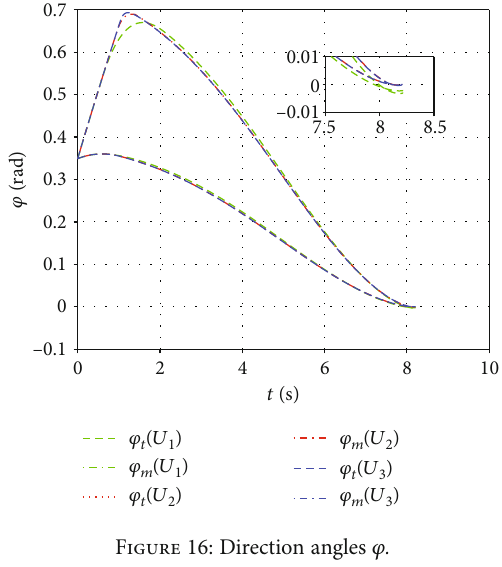
Figure 16: Direction angles φ .